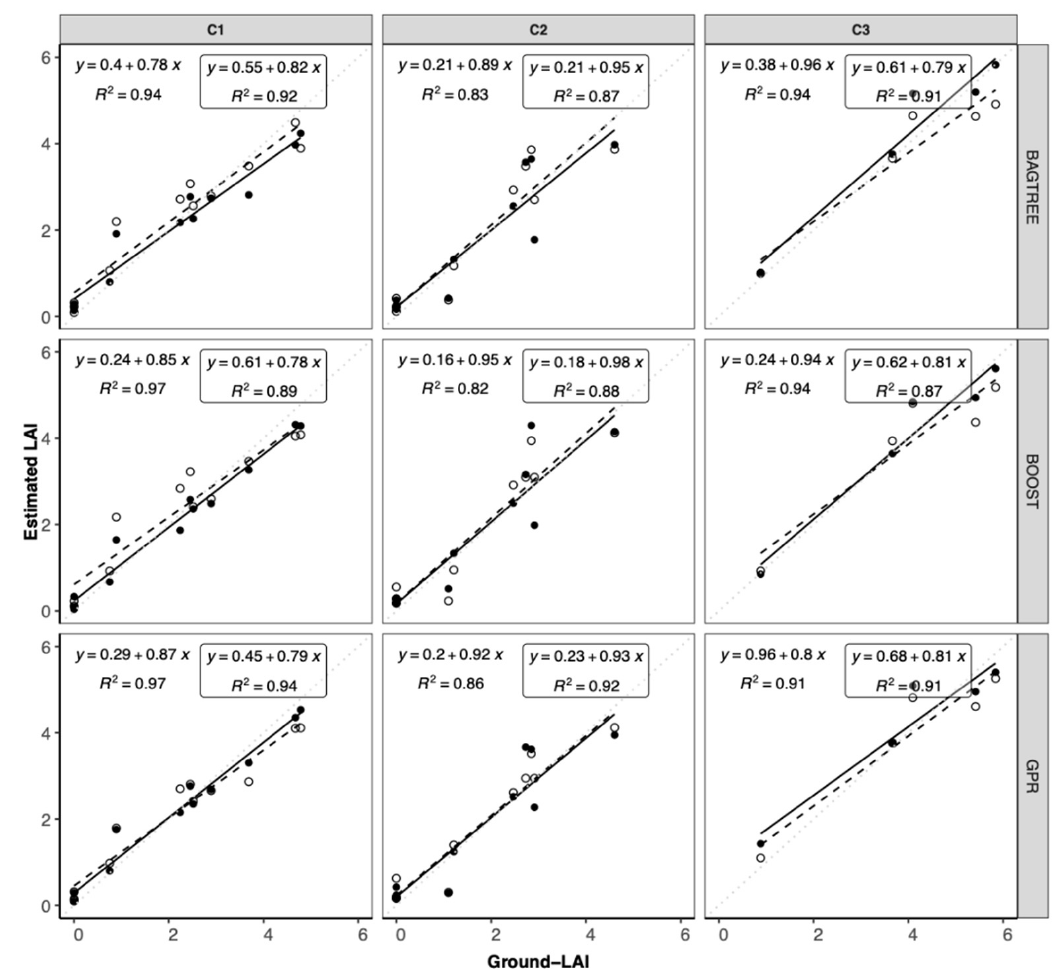
Figure 5. Validation results of LAI estimation at field level by GPR, BOOST, and BAGTREE. Results per crop (C1, C2, and C3) of the linear regression analysis between measured ground-LAI and LAI predicted from GPR, BOOST, and BAGTREE, according to the mixed-crop (MC) (dashed line on black dot and equation in the box) and crop-specific (CS) (continuous line on white dots) training data sets.